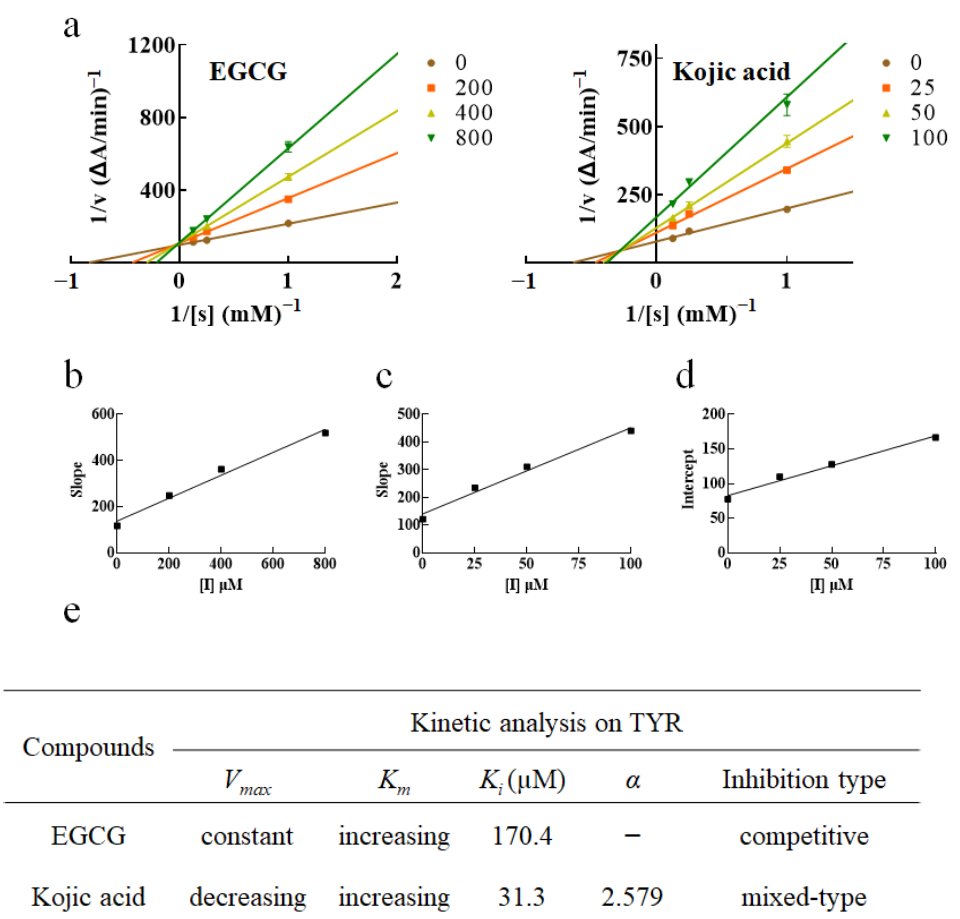
Figure 5. Inhibitory types and inhibitory constants of kojic acid and EGCG on MTYR: ( a ) Lineweaver – Burk plots on MTYR of EGCG and kojic acid; ( b ) Secondary replot of slopes (Lineweaver – Burk plot) vs various concentrations of EGCG; ( c , d ) Secondary plots of slopes and intercept (from Lineweaver – Burk plots) vs various concentrations of kojic acid; ( e ) Kinetic parameters and inhibition type of EGCG and kojic acid. Changes of V max and K m with the increasing compound molarity were shown. The substrate in the enzymatic reaction was L-DOPA. Inhibition constant, called K i , was calculated by replot of slopes (Lineweaver – Burk plot) vs various molarities of inhibitor [21]. K i is relevant to inhibitory activity of inhibitor, being the smaller the value of K i the stronger is the inhibitory activity [8]. K i values of